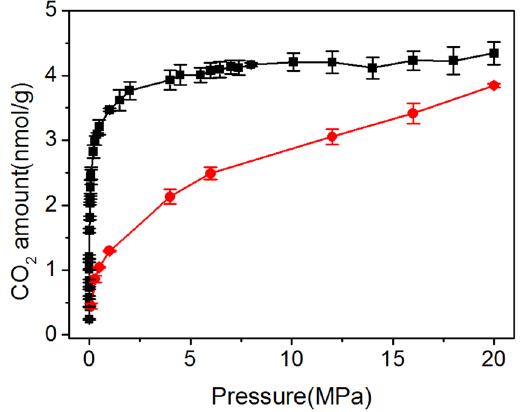
Figure 6. Adsorption isotherms of CO 2 by conventional GCMC method (black) and flexible adsorption method (red) in C1